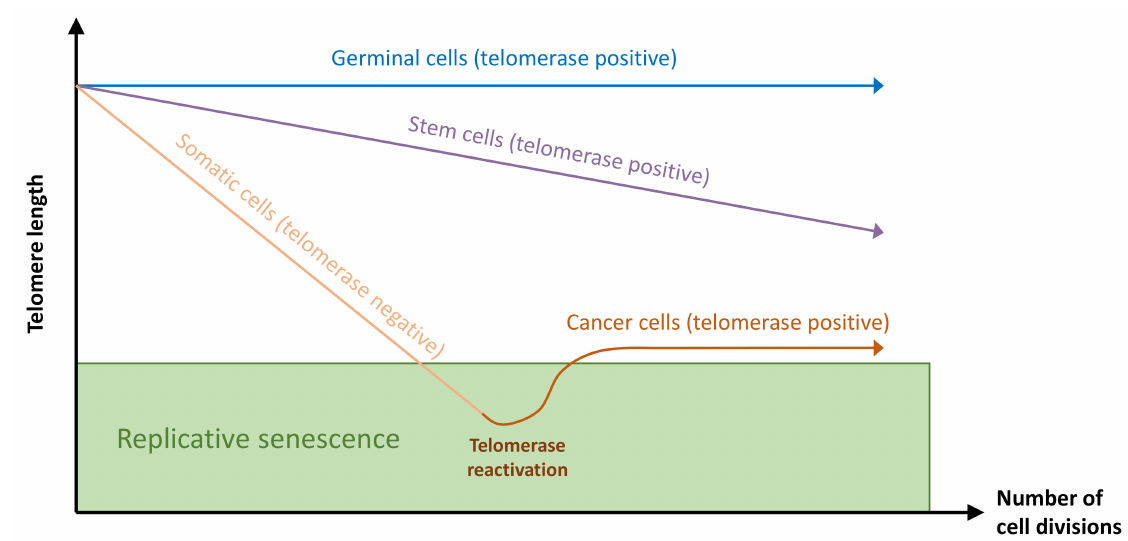
Figure 2. Telomere length dynamics in germinal, stem, somatic, and cancer cells according to the presence of telomerase activity. In germinal and stem cells, active telomerase can offset telomere attrition due to cell divisions. In somatic cells, telomerase is inactive, and telomere length is shortened until it reaches a threshold that triggers replicative senescence. Cancer cells can bypass cell senescence by the reactivation of